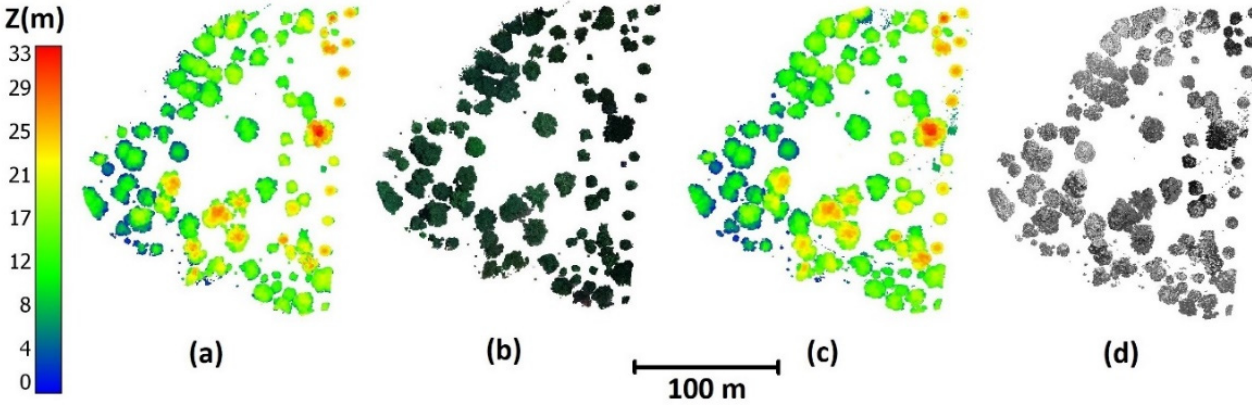
Figure 8. 3D non-ground points: ( a ) height-coded photogrammetric point cloud; ( b ) colourised Photogrammetric point cloud; ( c ) height-coded LiDAR point cloud and ( d ) intensity of LiDAR point cloud.